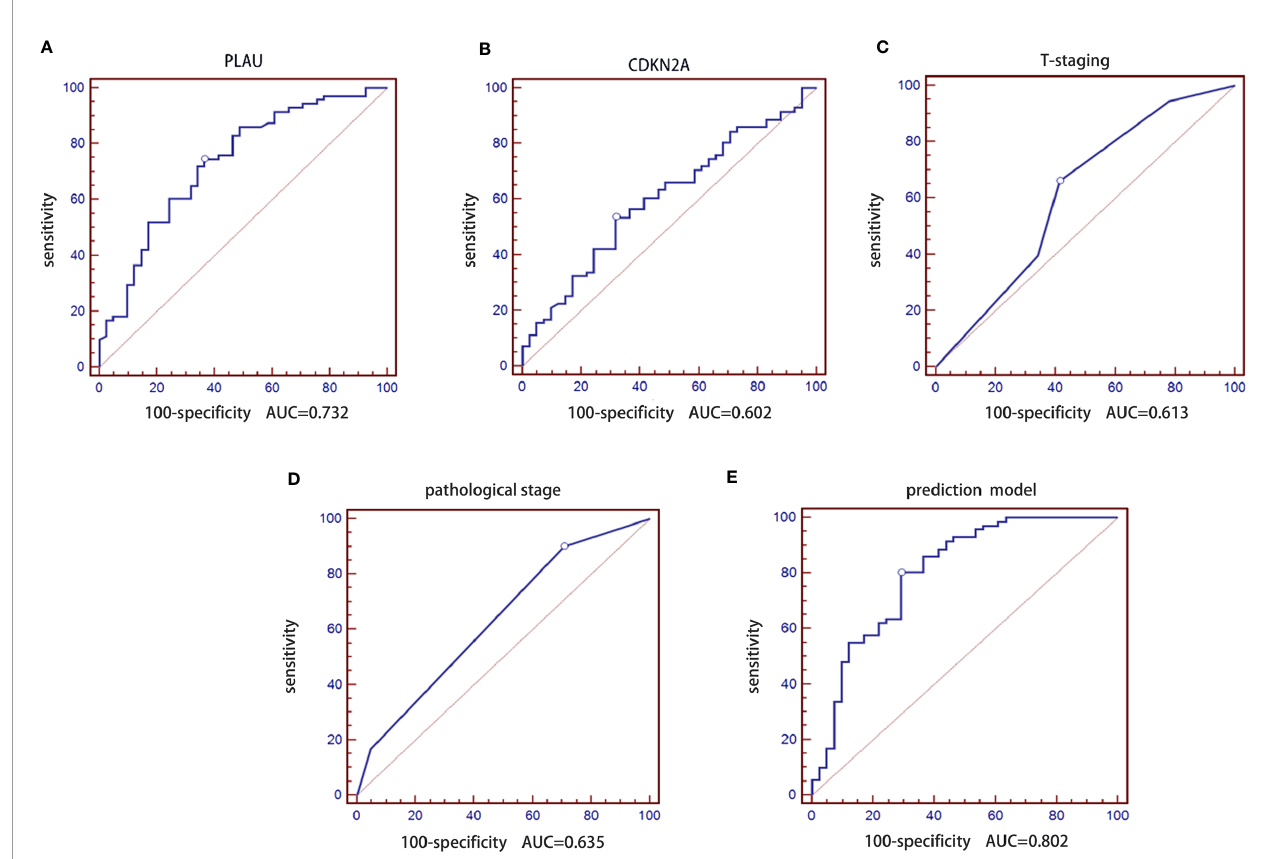
FIGURE 3 | Construction of a prediction model of lymph node metastasis based on the CDKN2A and PLAU genes combined with clinicopathological parameters in the retrospective group. (A) ROC curve of the PLAU gene; (B) ROC curve of the CDKN2A gene; (C) ROC curve of T stages; (D) ROC curve of pathological grades; (E) ROC curve of the constructed prediction model.